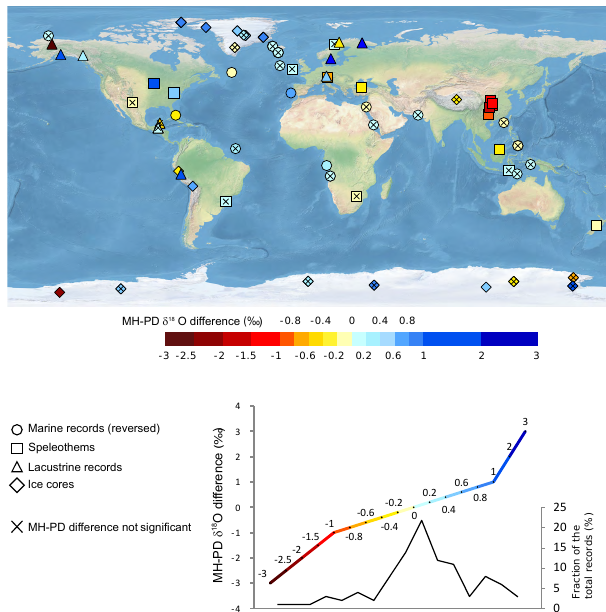
Figure 9. Same as Fig. 8 but for the difference between LIG and MH values (LIG-MH).